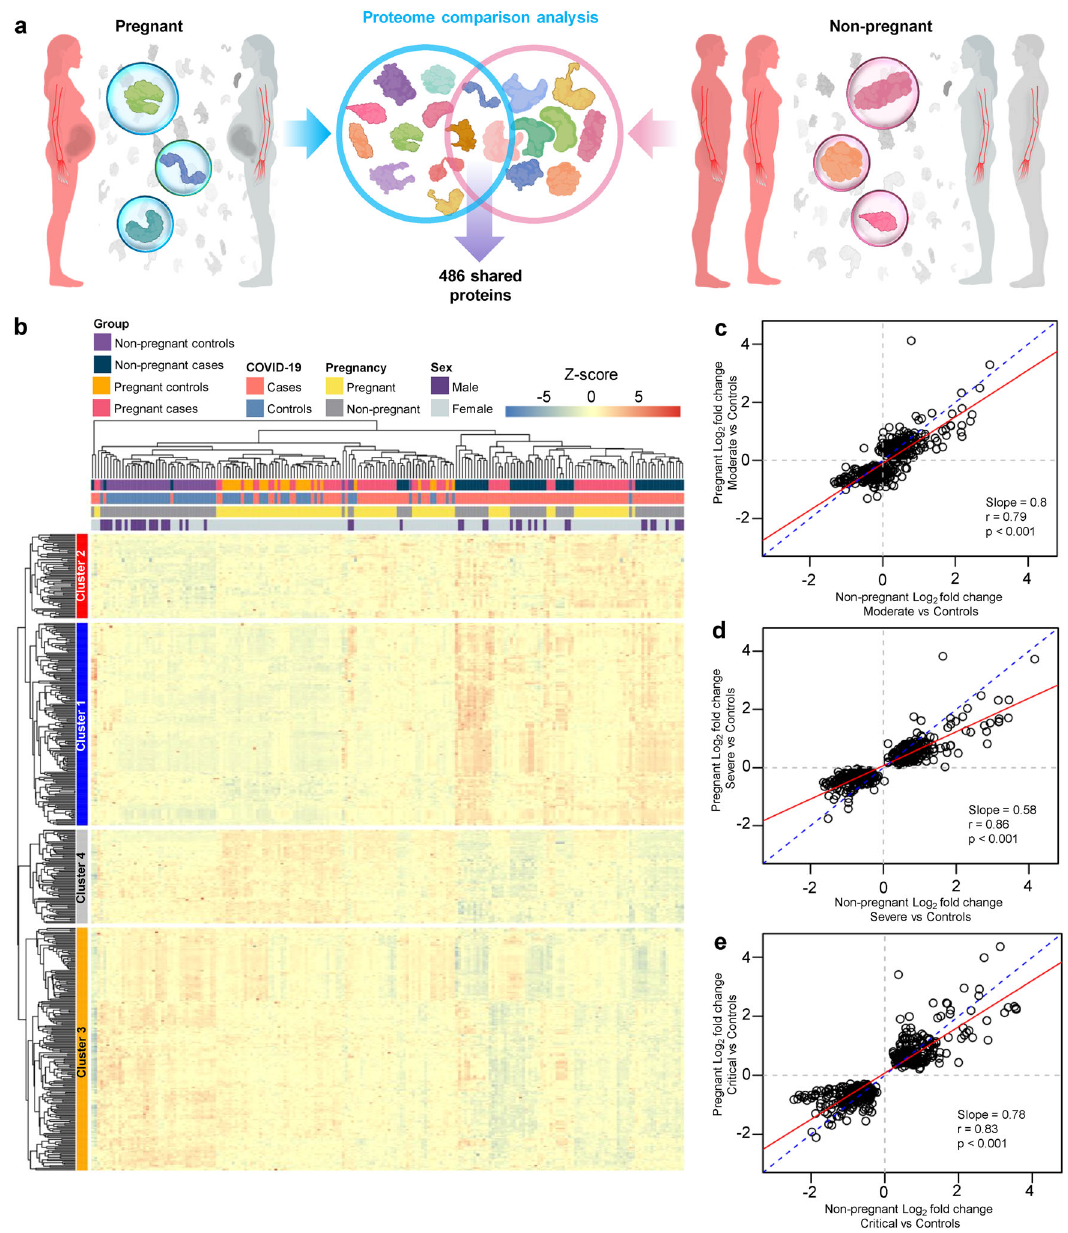
Fig. 4 The protein response to COVID-19 is dampened in pregnancy regardless of disease severity. a Graphical representation showing the comparison of 486 plasma proteins that are modulated in both pregnant COVID-19 cases vs. controls and in non-pregnant COVID-19 cases vs. controls. b Heatmap representation of the 486 proteins with shared dysregulation between pregnant and non-pregnant COVID-19 patients. Clusters 1 and 2 include proteins with increased abundance while clusters 1 and 3 include proteins with decreased abundance in cases compared to controls. c Correlation between the magnitude of proteomic changes in pregnant moderate cases vs. controls and that in non-pregnant moderate cases vs. controls. Slope of the regression line (red line), Spearman ’ s correlation, and p-value are provided. Dotted blue line represents the parity line. d Correlation between the magnitude of proteomic changes in pregnant severe cases vs. controls and that in non-pregnant severe cases vs. controls. e Correlation between the magnitude of proteomic changes in pregnant critical cases vs. controls and that in non-pregnant critical cases vs.